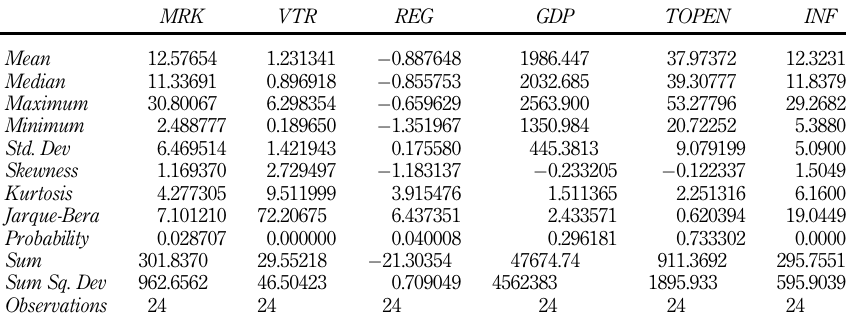
Table 3. Variable description and sources